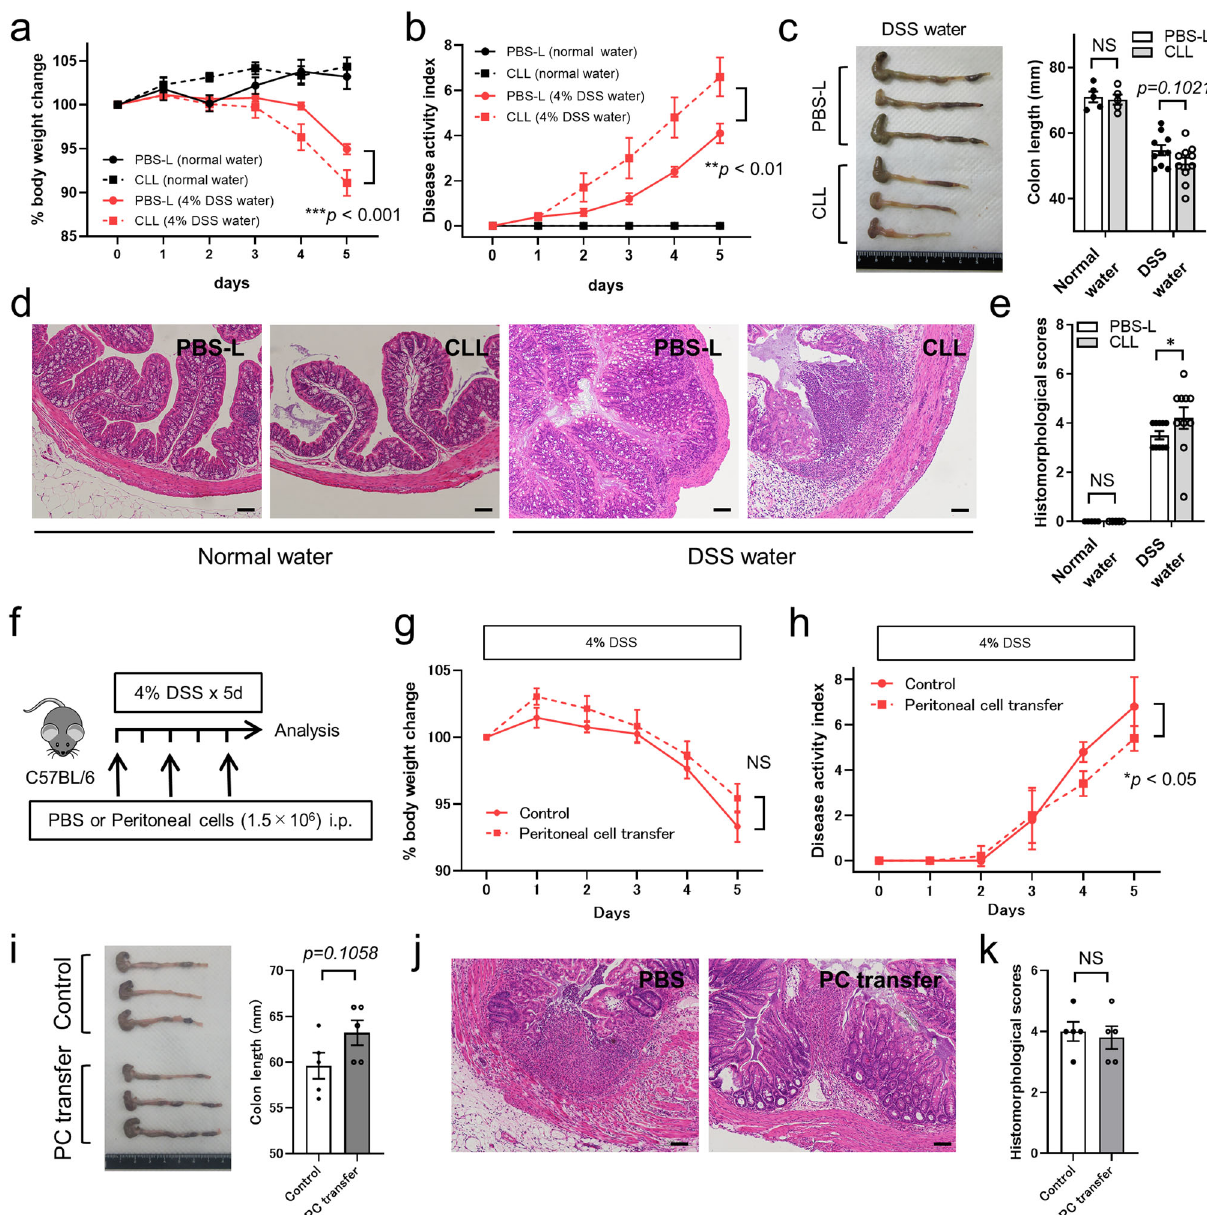
Fig. 7 Peritoneal macrophages exert a tissue repair function in DSS-induced colitis. a Body weight change of PBS-L treated control and CLL-treated mice in 4% DSS-induced colitis. n = 5 (normal water group treated by PBS-L or CLL) and 20 (DSS water group treated by PBS-L or CLL). Data were pooled from three independent experiments. b Disease activity index of PBS-L treated control and CLL-treated mice in 4% DSS-induced colitis. n = 5 (normal water group treated by PBS-L or CLL) and 10 (DSS water group treated by PBS-L or CLL). c Macroscopic fi ndings of the colon 5 days after the start of 4% DSS- containing water (left) and quanti fi cation of colon length (right). n = 5 (normal water group treated by PBS-L or CLL) and 10 (DSS water group treated by PBS-L or CLL). d Representative H&E staining of the colon 5 days after the start of 4% DSS-containing water and e quanti fi cation of histomorphological scores. n = 5 (normal water group treated by PBS-L or CLL) and 10 (DSS water group treated by PBS-L or CLL). Scale bars, 100 μ m. f Schematic protocol for peritoneal cell (PC) transfer experiments in DSS-induced colitis. g Body weight change and h disease activity index of PBS-treated control and PC-treated mice in 4% DSS-induced colitis. n = 5/group. i Macroscopic fi ndings of the colon 5 days after the start of 4% DSS-containing water (left) and quanti fi cation of colon length (right). n = 5/group. j Representative H&E staining of the colon 5 days after the start of 4% DSS-containing water and k quanti fi cation of histomorphological scores. n = 5/group. Scale bars, 100 μ m. Data represent mean ± SEM. * p < 0.05, ** p < 0.01, *** p < 0.001. P values were calculated with two-tailed unpaired Student t -test ( c , i ), Mann – Whitney U- tes t ( e , k ), and two-way repeated-measures ANOVA ( a , b , g , h ). Source data are provided as a Source Data fi